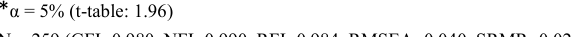
Structural model evaluation Relationship Path Coefficient t-Value Conclusion 0.56 8.38* Significant